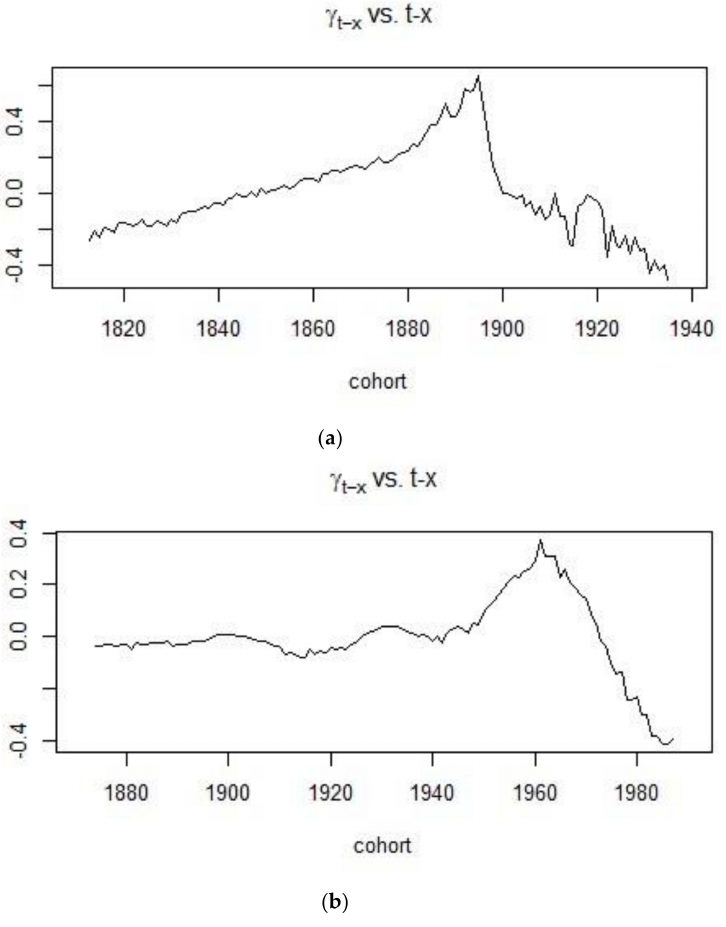
Figure 6. The evolution of the parameter showing the cohort effects during the ( a ) 1900–1938 period and ( b ) 1961–1990